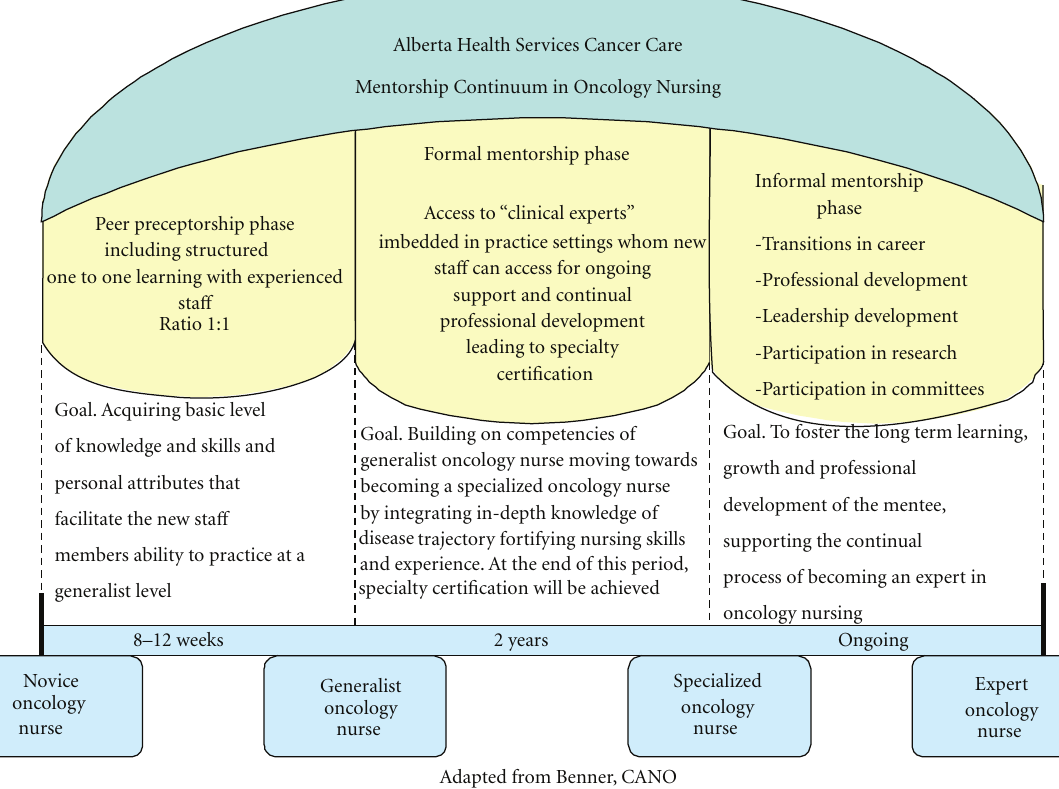
Figure 1: Conceptual model of mentorship as overarching